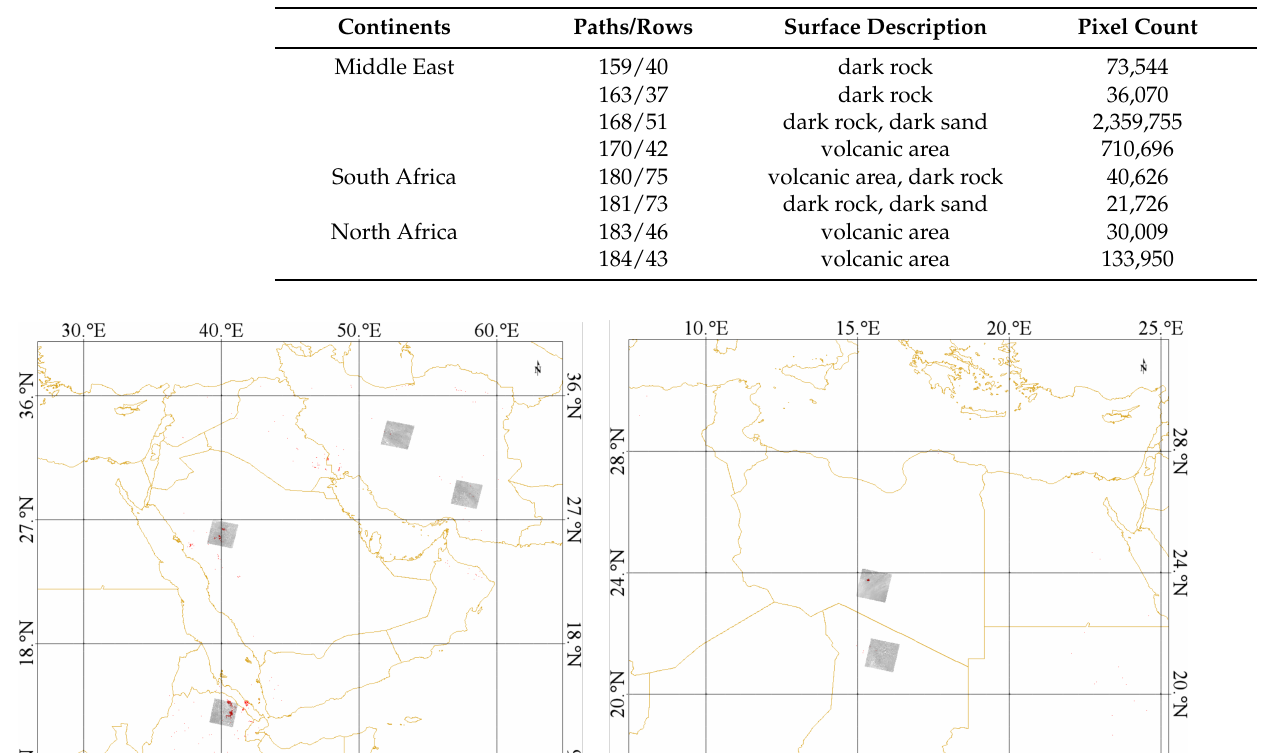
Table 2. Showing WRS-2 paths/rows, surface types, and pixel count across different continents.